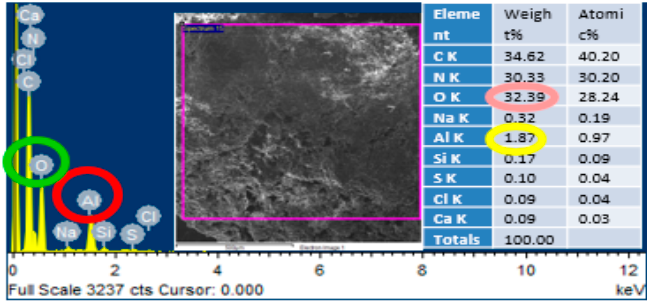
Figure 6. EDS analysis of urea-formaldehyde resin containing 3% alumina nanoparticles.